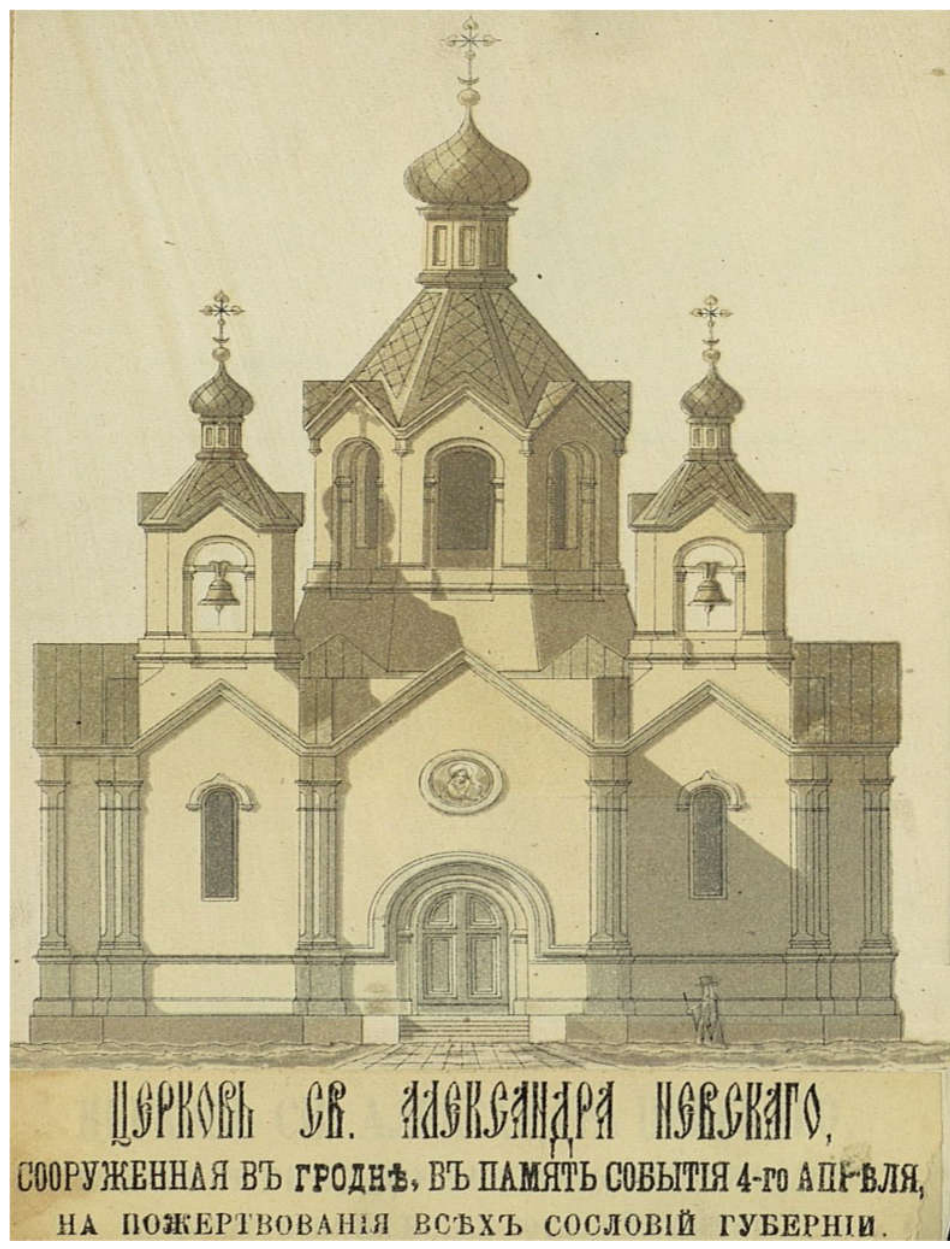
Figure 4. Source: Pamyatnaya Knizhka Grodnenskoy Gubernii na 1871 god , Chast’ 2 (1871).